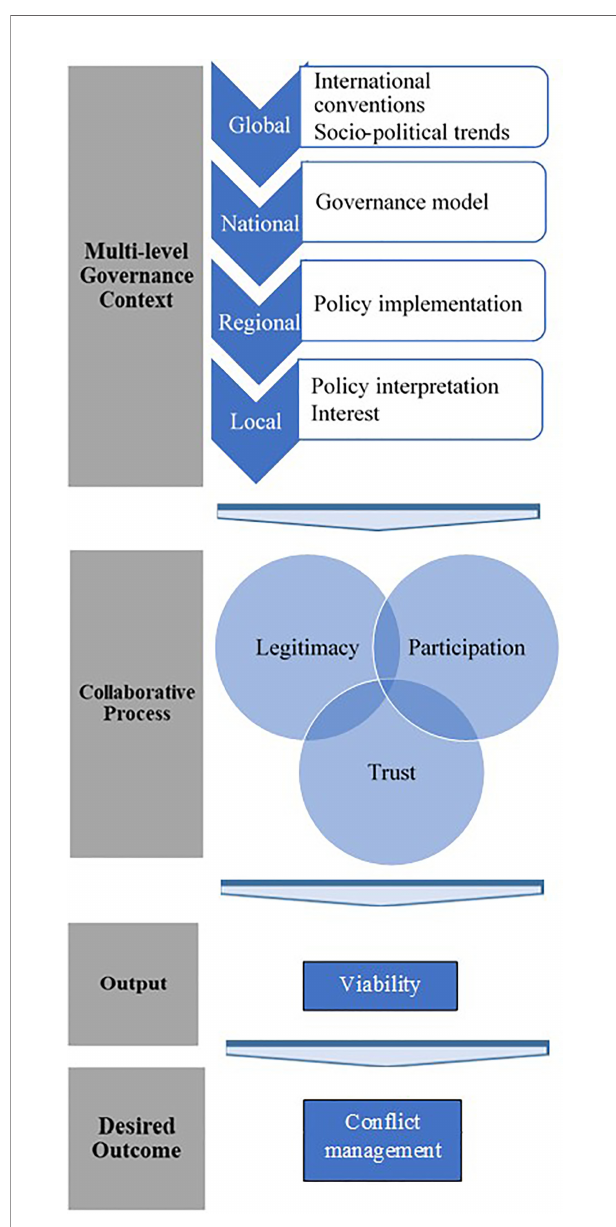
FIGURE 1 | Collaboration in a Multi-Level Governance